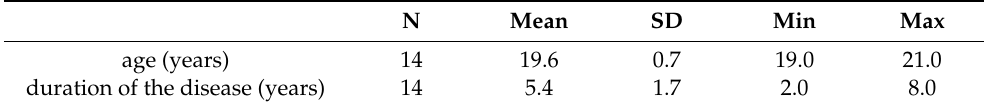
Table 1. Patient